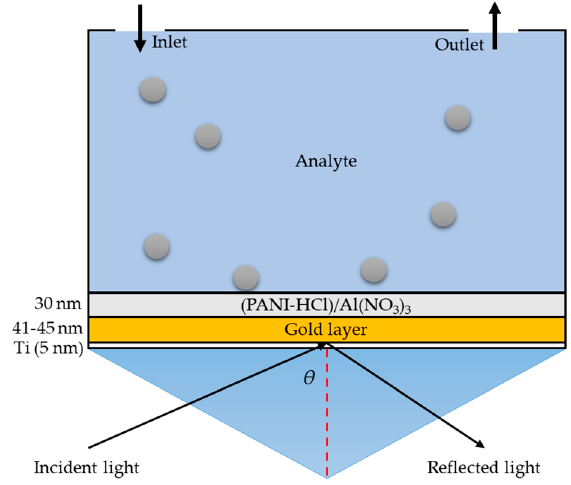
Figure 10. Kretschmann configuration employed in SPR-microscopy sensor: a glass prism, titanium adhesion layer (5 nm), gold layer (41–45 nm), and (PANI-HCl)/Al(NO 3 ) 3 complex composite layer (30 nm) with an analyte for sensing biomolecules.